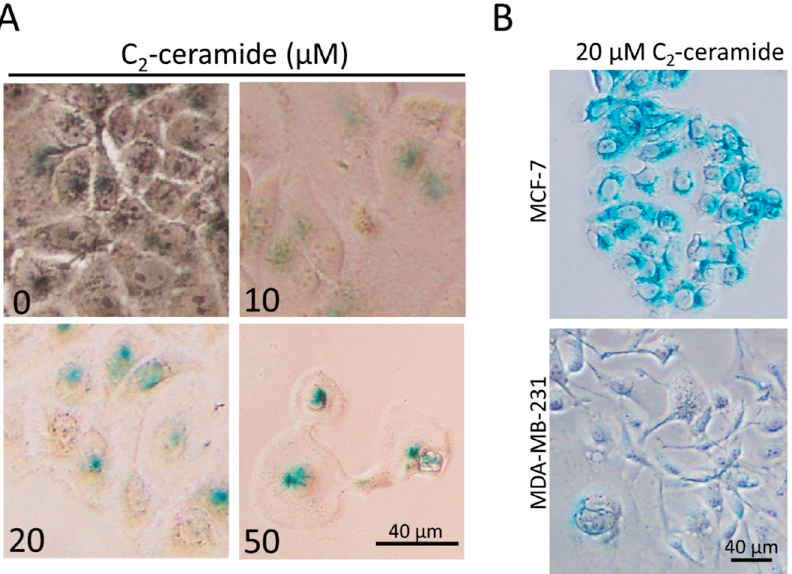
Figure 2. The detection of senescence-like phenotype using SA- β -gal staining. ( A ) MCF-7 cells were treated with the indicated doses of C 2 -ceramide for six days respectively. Afterward, the cells were glutaraldehyde-fixed and stained with the substrate X-gal (pH 6.0) for 24 h. Nought indicates the cells were treated with C 2 -ceramide-free solvent as vehicle control. ( B ) Breast cancer cells were cultured with 20 µ M C 2 -ceramide respectively. The stained cells with green around the peri-nuclear regions were considered to be senescent cells.